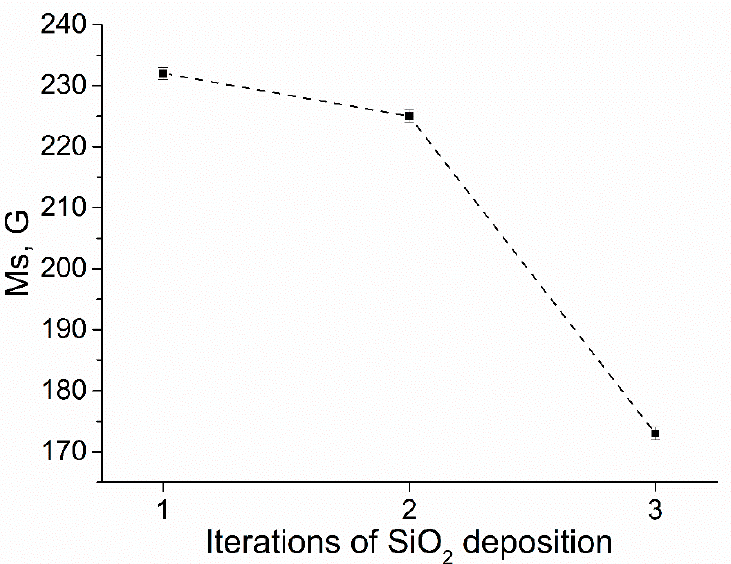
Figure 8. Saturation magnetization for one, two, and three iterations of deposition of the dielectric shell.